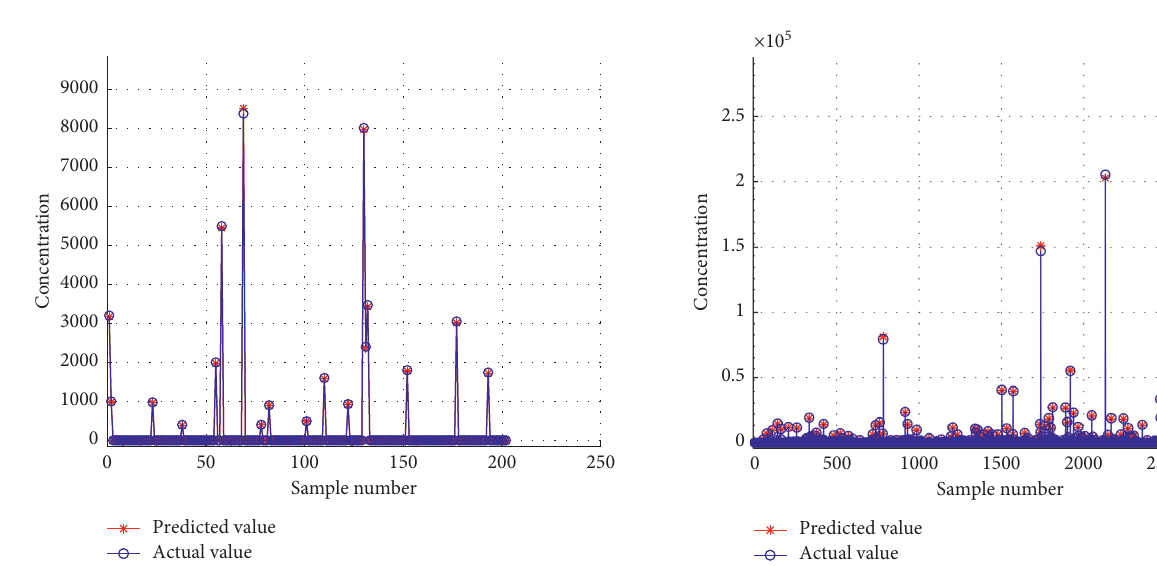
Figure 14: The fitting effect diagram of Weifang training set data.